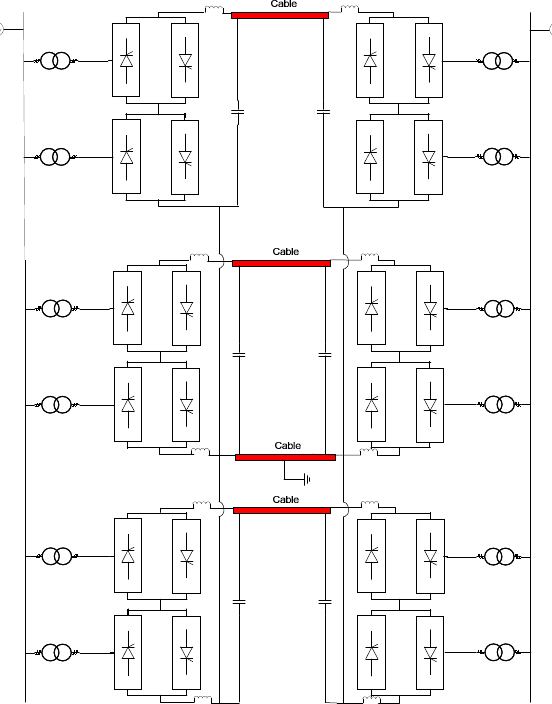
Figure 9. Configuration of three ‐ phase low frequency ac transmission system.